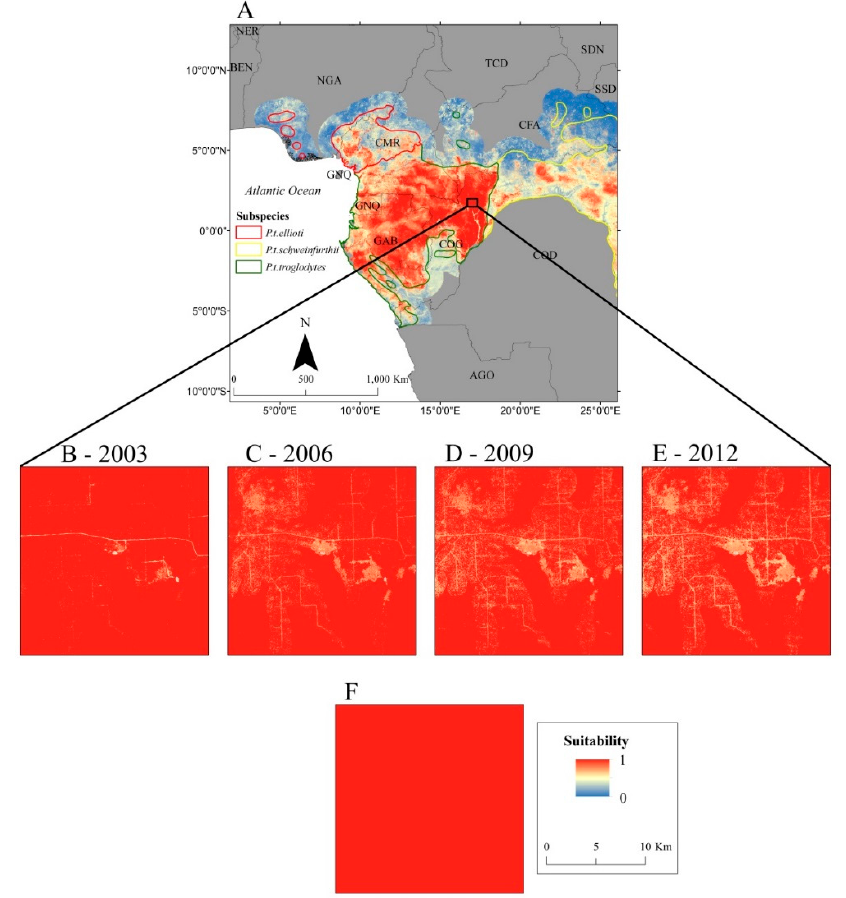
Figure 7. Suitability values predicted by a Random Forests model for Central Africa ( A ); an area experiencing selective logging circa 2003 ( B ); circa 2006 ( C ); circa 2009 ( D ); circa 2012 ( E ) and the area as depicted in Reference [25] ( F ).